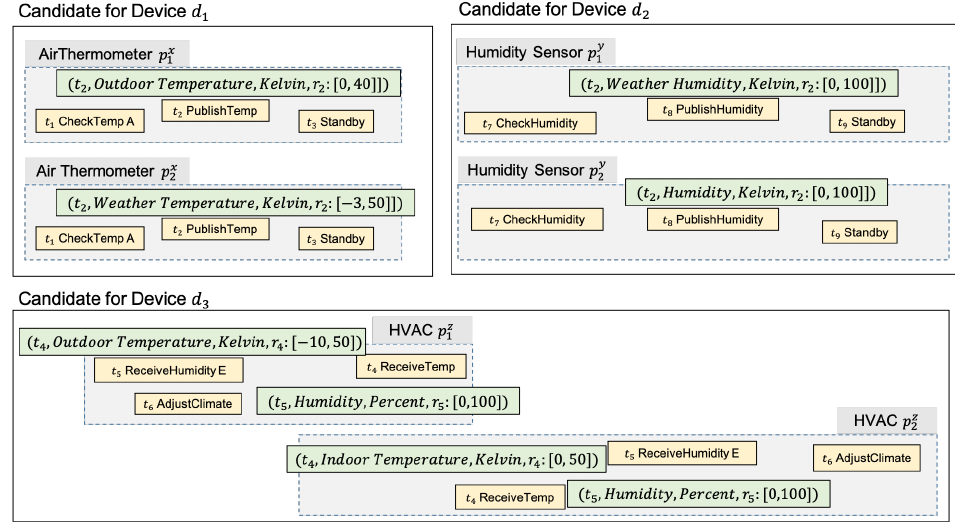
Figure 10. Example group of physical devices for S HVAC